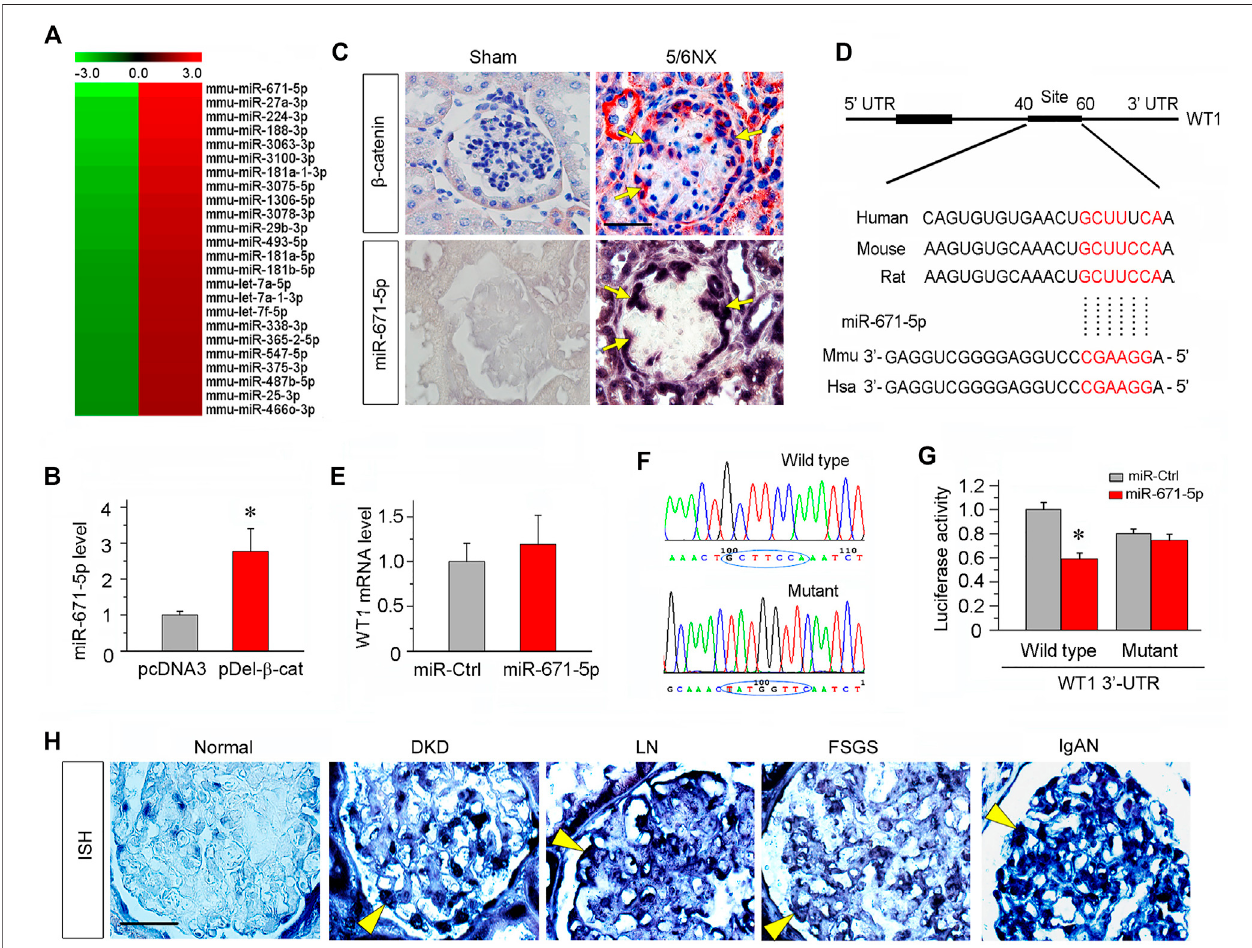
FIGURE1| miR-671-5pisinducedby β -catenininpodocytesandtargetsWT1. (A) MicroarraychipanalysisofmiRNAsexpressionindifferentgroups(left:pcDNA3 control group; right: pDel- β -cat group). The red and green colors indicated high or low expression, respectively. (B) Mouse podocytes (MPC5) were transfected with empty vector (pcDNA3) or β -catenin expression plasmid (pDel- β -cat) for 24 h. qRT-PCR analysis showed the expression of miR-671-5p in different groups. * p < 0.05 ( n (cid:1) 3). (C) Co-localizationof β -cateninandmiR-671-5pinglomerularpodocytesofdiseasedkidney.Kidneyserialsections(3 μ m)of5/6NXmiceweresubjectedto immunostainingfor β -cateninand insitu hybridizationformiR-671-5p.Representativemicrographsfromshamgrouparealsoshown.Arrowsindicatepositivestainingin podocytes.Scalebar,20 µm. (D) Bioinformaticsanalysisshowsthepredicted bindingsitesofmiR-671-5p intheWT13 ′ -untranslatd region(UTR)usingtheTargetScan software. (E) qRT-PCR analysis shows that overexpression of miR-671-5p did not affect WT1 mRNA level in mouse podocytes. MPC5 cells were transfected with miRNAnegativecontrol(miR-Ctrl)ormiR-671-5pmimics(miR-671-5p)for24 h. (F) SequencevalidationofthewildtypeormutantWT13 ′ -UTRfortheluciferasereporter construction. The wild-type miR-671-5p binding site in WT1 3 ′ -UTR (upper) and the mutated one (bottom) in the region corresponding to the miR-671-5p seed sequence are shown. (G) Luciferase reporter assay show that miR-671-5p mimics decreased the luciferase activity in 293T cells co-transfected with wild-type WT1 3 ′ UTR,butnotwithmutantWT13 ′ UTR.* p < 0.05. (H) RepresentativemicrographsshowmiR-671-5pexpressioninglomerularpodocytesofhumankidneybiopsiesfrom the patients with various CKDs by in situ hybridization. Arrowheads indicate the positive staining for miR-671-5p in glomerular podocytes. Kidney tissues adjacent to renal cell carcinoma from patients who underwent carcinoma resection were used as normal control. Scale bar, 20 µm.